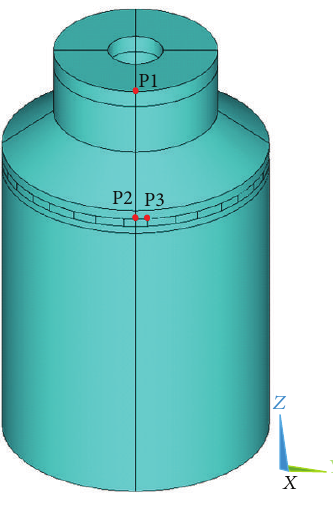
Figure 1: The geometry of shield building.